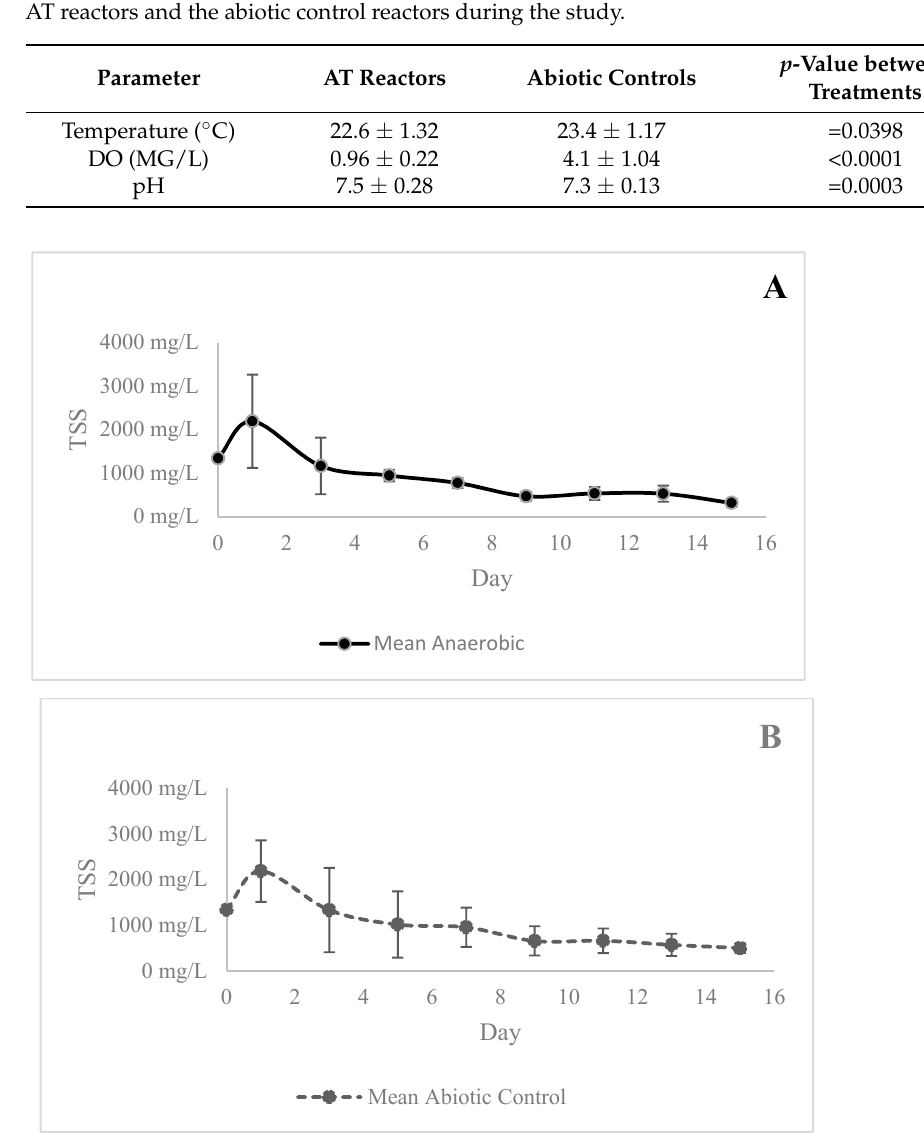
Figure 2. Reactor TSS concentrations. Mean TSS concentrations within AT treatment ( A ) and abiotic control ( B ) replicates throughout the 15-day study period. Error bars indicate standard deviation between treatment replicates.